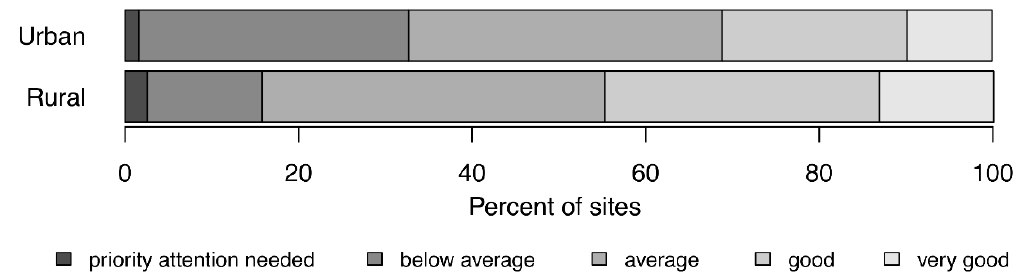
Figure 4. Distribution of qualitative audit scores assessing the quality of WSP implementation.